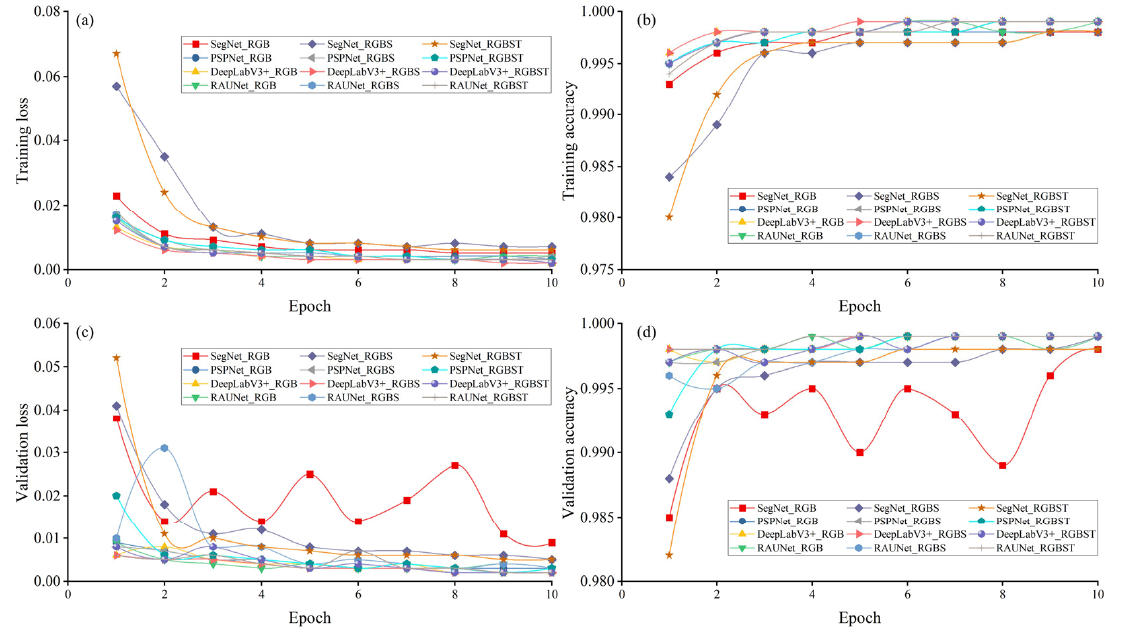
Figure A4. Training and validation curves for one-class classification of EC. ( a ) Training loss; ( b ) training accuracy; ( c ) validation loss; ( d ) validation accuracy.